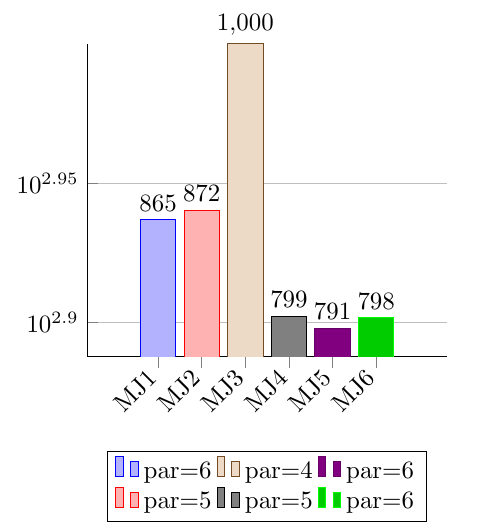
Figure 5: Model error, when optimizing model param- eters for variable displacement.